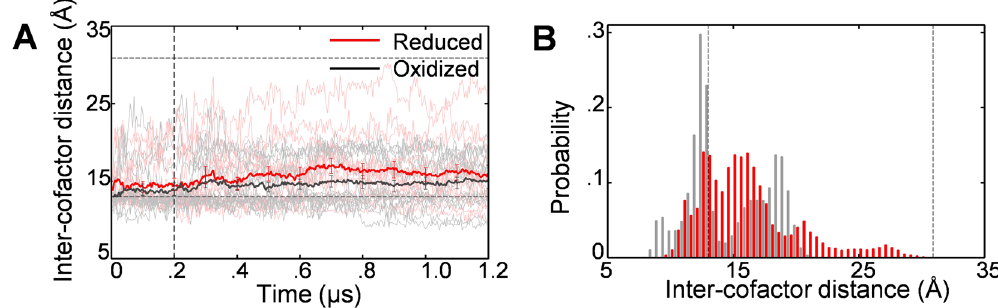
Figure 2. Redox-state dependence of FAD-FMN inter-cofactor distance (the distance between the center of mass of the alloxazine ring of FAD cofactor and that of the FMN cofactor). ( A ) Average time course of the inter- cofactor distance, starting from the closed form [0–0.2 μ s: cMD, 0.2–1.2 μ s: aMD; 16 individual time courses are also shown (oxidized: gray, reduced: pink)]. Horizontal lines indicate the values for the crystal structures. ( B ) Probability distributions of the inter-cofactor distance for the oxidized (gray) and reduced (red) states calculated using reweighted data for the last 0.5 μ s.